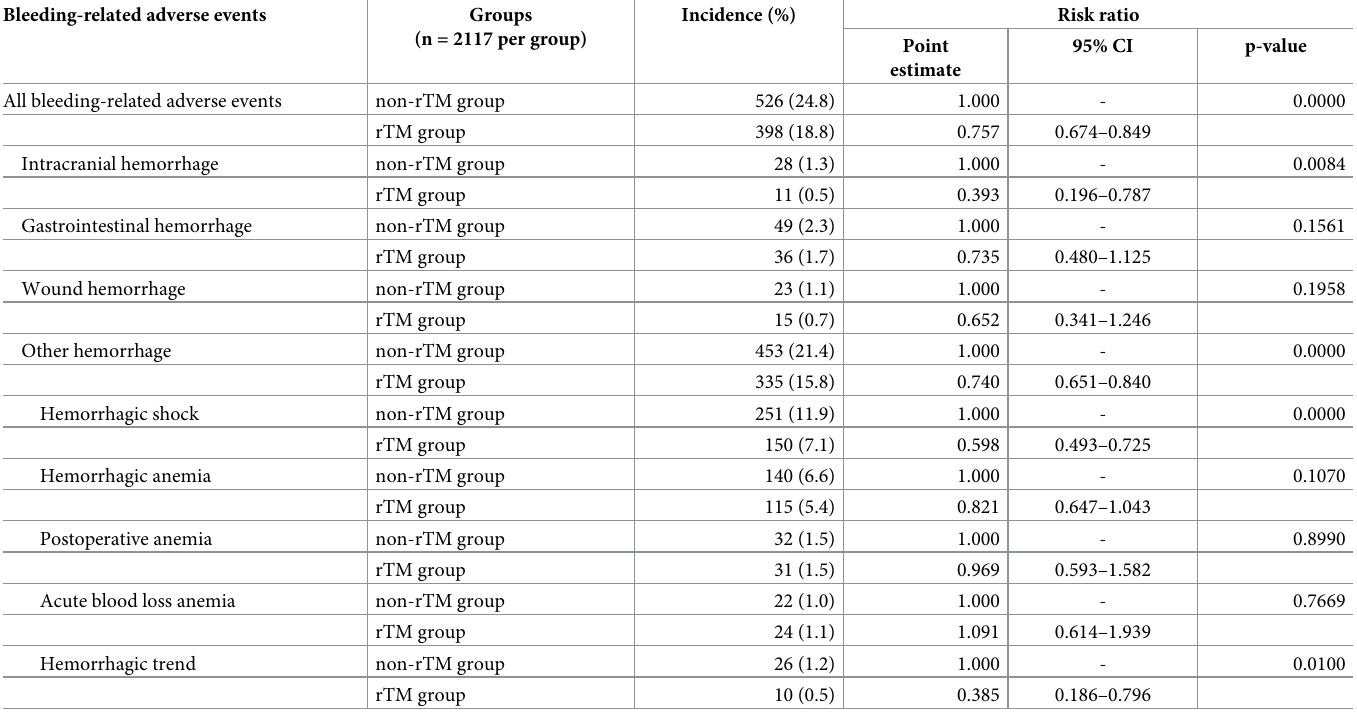
Table 2. Bleeding-related adverse events with an incidence > 1% in patients undergoing any type of surgery. Bleeding-related adverse